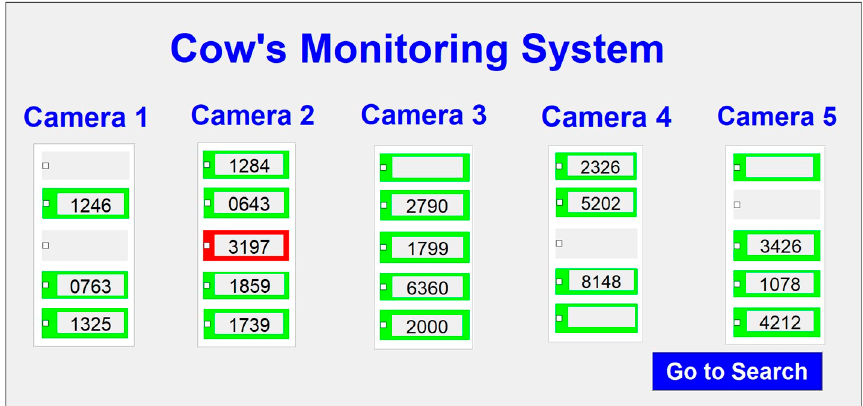
Figure 23. The search system form with detail information.